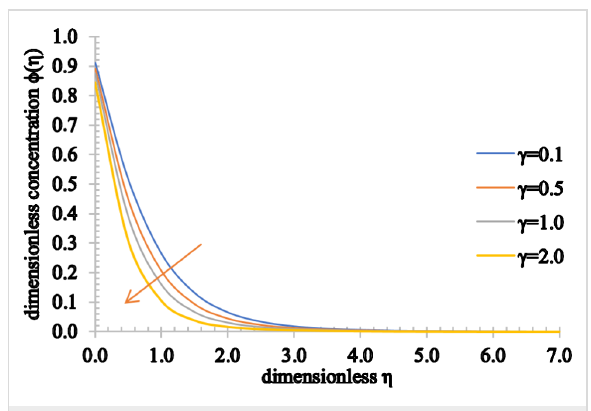
Figure 17: The concentration profile for increasing values of γ .